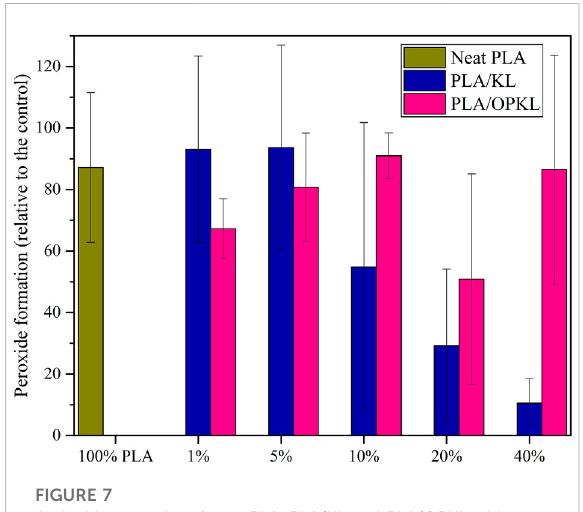
FIGURE 7 Antioxidant results of neat PLA, PLA/KL and PLA/OPKL with respect to the control at 234 nm in